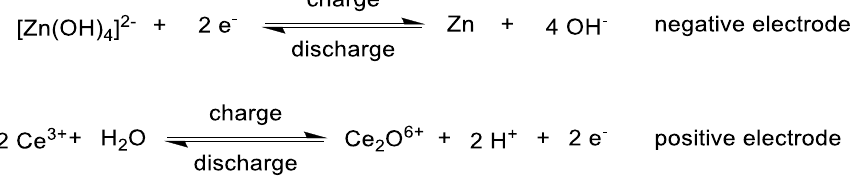
Figure 5. Reactions of the zincate-cerium redox-flow system for the negative electrode in the catholyte compartment ( above ) and the positive electrode in the anolyte compartment ( below ).